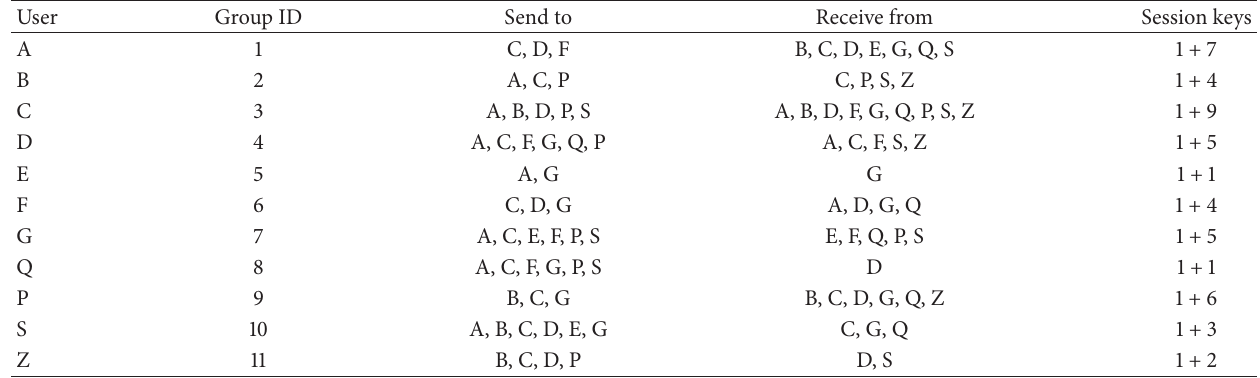
Table 5: Group IDs and session keys for each node after joining of a new node.